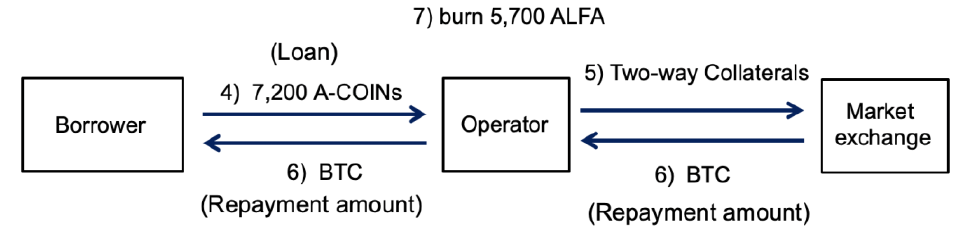
Fig. 3. The repayment process of A-COIN (the investments are withdrawn from the market exchange and returned to the borrower on